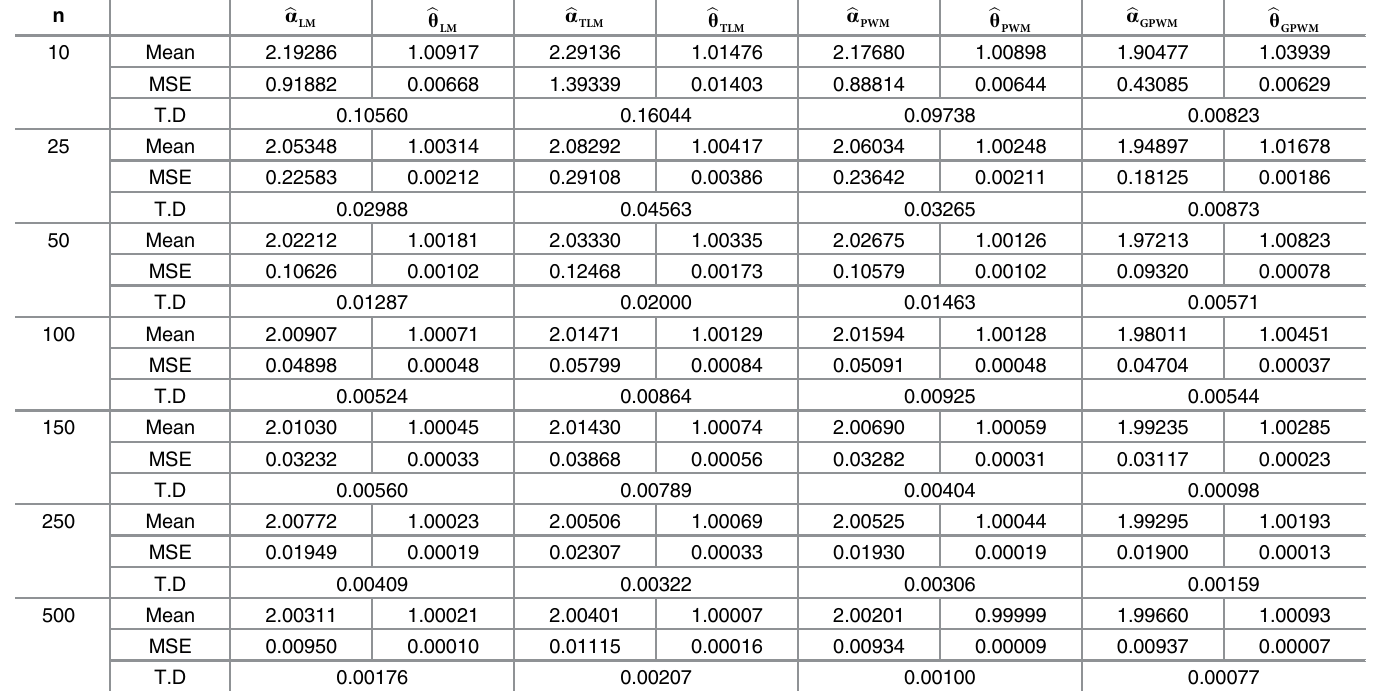
Table 4. Comparison of the estimation methods for ( α = 2, θ = 1).